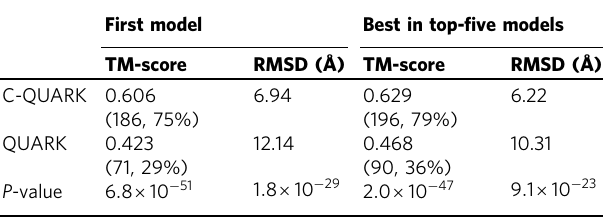
Table 1 Summary of structure modeling by C-QUARK and QUARK on the 247 test